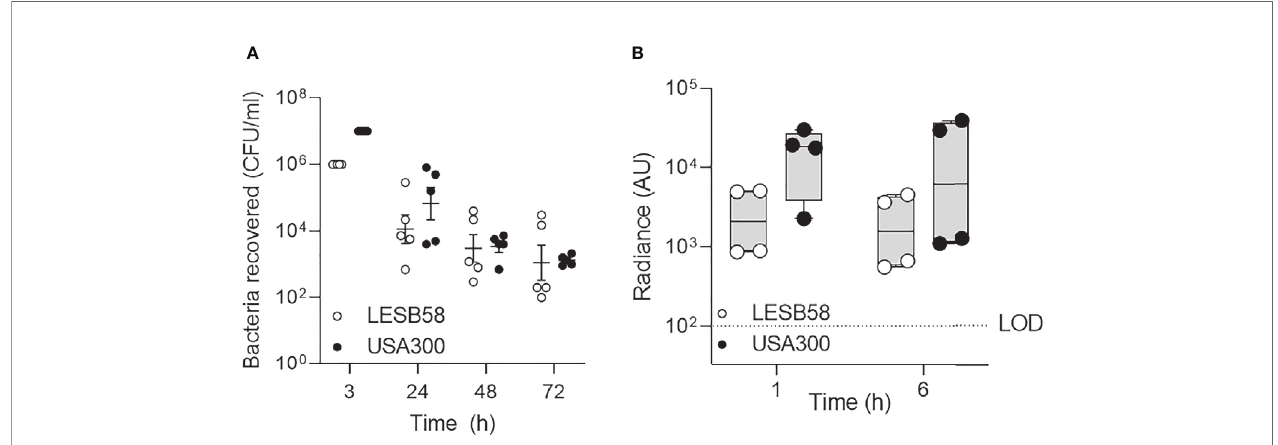
FIGURE 1 | Clinically important species of bacteria established acute intranasal infection and elicited reactive oxygen species production. P. aeruginosa LESB58-Lux or S. aureus USA300-Lux were inoculated dropwise in the left naris of C57Bl/6 mice (10 6 or 10 7 CFU, respectively). (A) Bacteria were recovered up to 72-h post- infection by nasal lavage. (B) Localization of oxidative species to the site of infection was tracked using the chemiluminescent L-012 sodium salt probe (25 mg/kg). Radiance was quanti fi ed 1- and 6-h post-infection across species. Infection with S. aureus USA300 resulted in a signi fi cantly stronger oxidative response than P. aeruginosa LESB58 1 h post-infection. The limit of detection (LOD) is shown as a dotted line at 10 2 counts. n = 4 per time point. Data are shown as mean ±